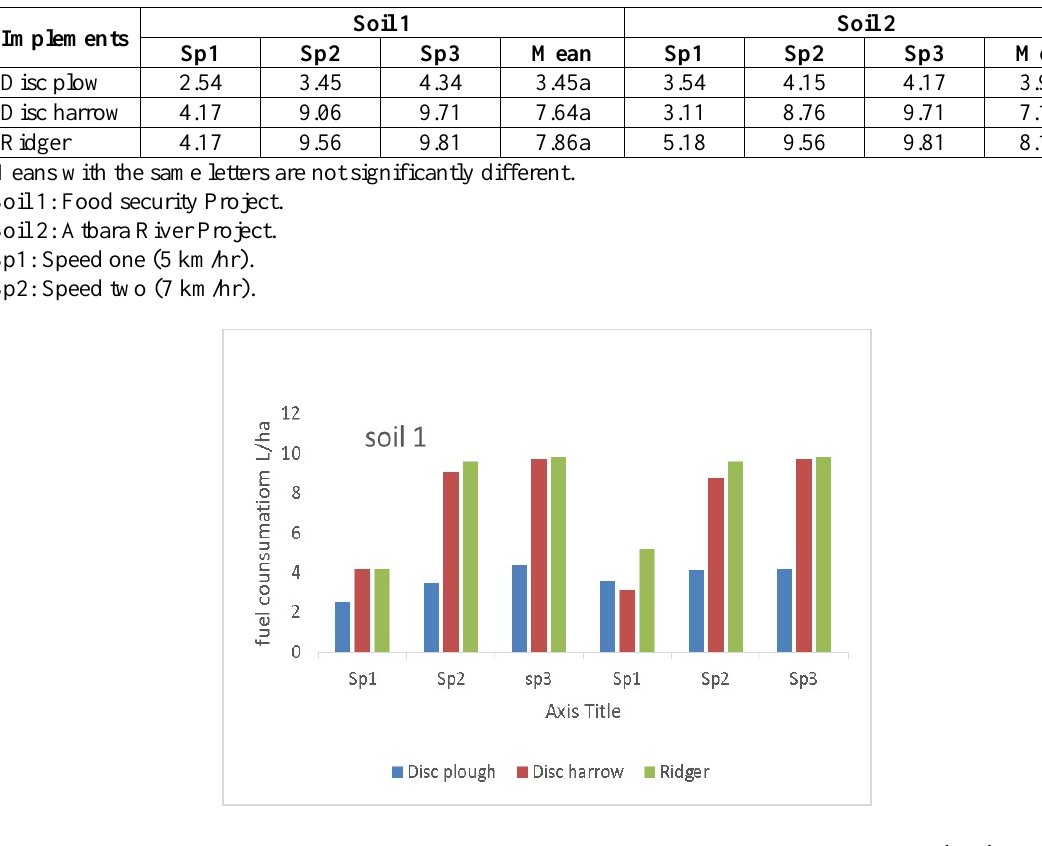
Figure 4. Effect of different forward speeds and tractors power on fuel Consumption (l/hr) at two different